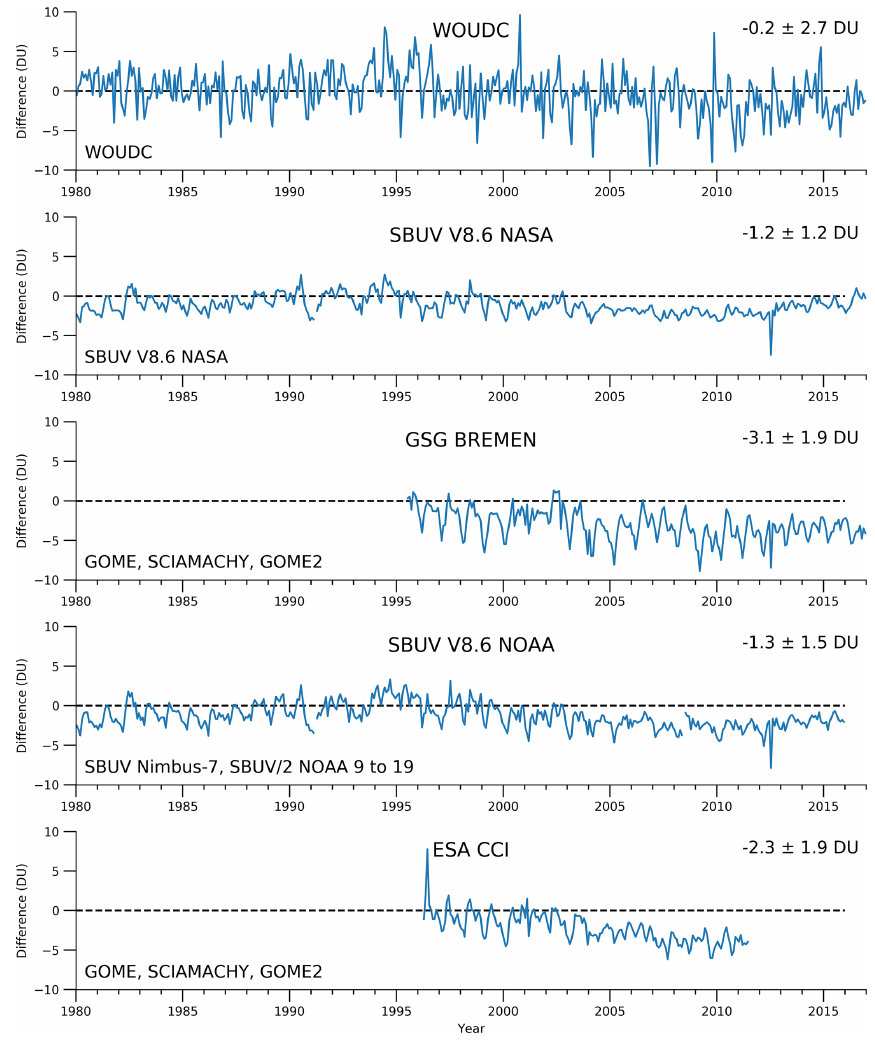
Figure 6. Area-weighted global mean monthly mean differences in TCO between the NIWA-BS database and the validation databases detailed in Table 3. The topmost panel shows the differences between the NIWA-BS database and the ground-based TCO database obtained from the WOUDC. The remaining four panels show differences against databases derived from space-based measurements. The statistics in the top right corner of each panel show the mean difference and standard